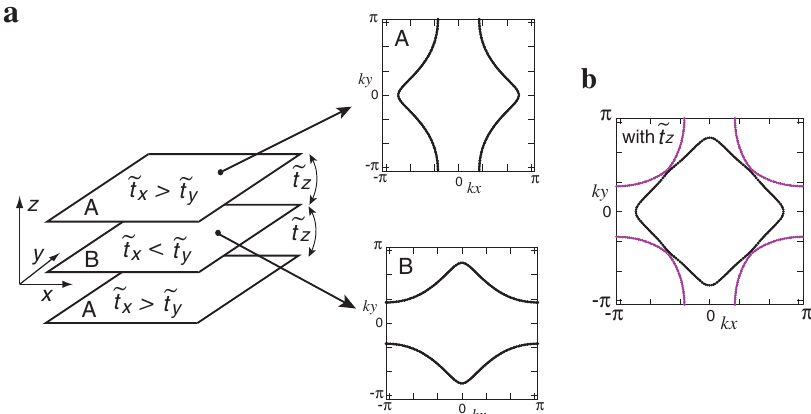
Fig. 3 Fermi surface (FS) deformation in La 2 − x Sr x CuO 4 . a Alternate stacking of strongly deformed FSs due to the underlaying nematicity in each CuO 2 plane. ~ t x and ~ t y are the effective in-plane hopping integrals along the x and y directions, respectively; ~ t z is the effective hopping along the z direction; see Supplementary Note 2 for more details. b The resulting bulk FSs, which become two-dimensional and consist of inner (black) and outer (purple) FSs.